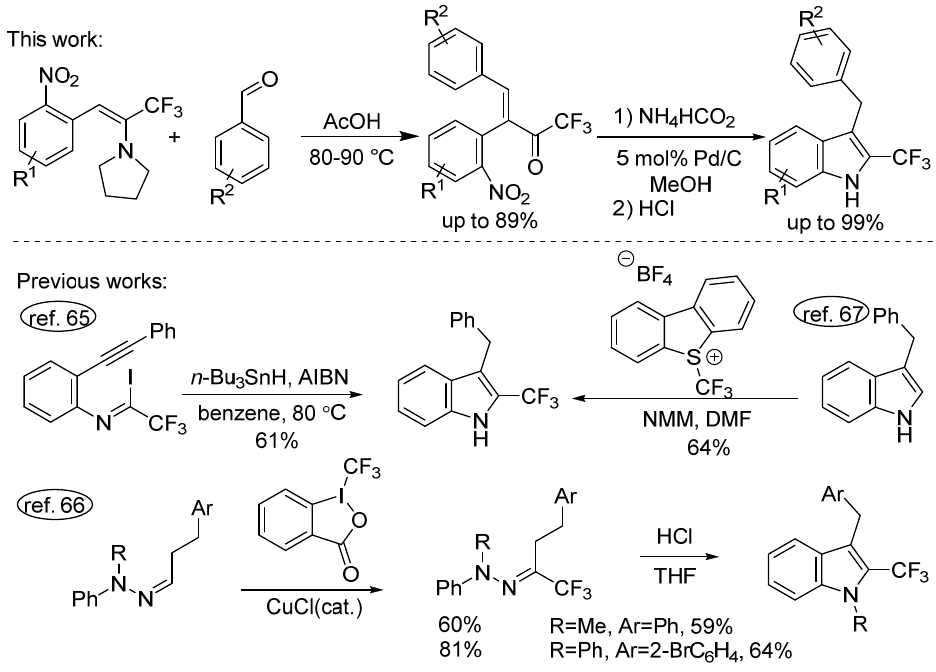
Figure 2. Approaches to 2-CF 3 -3-benzylindoles .